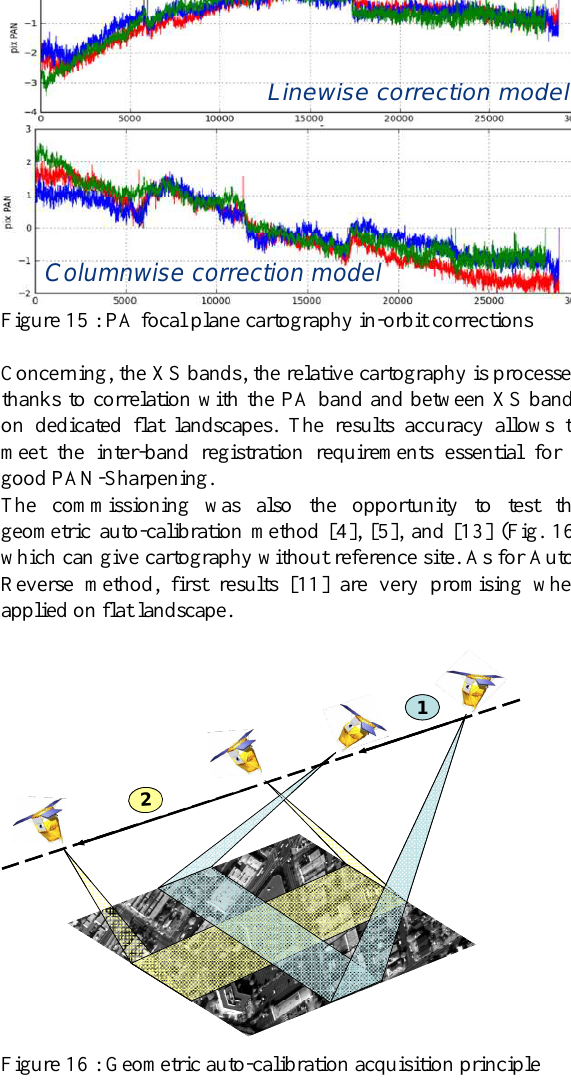
Figure 16 : Geometric auto-calibration acquisition principle